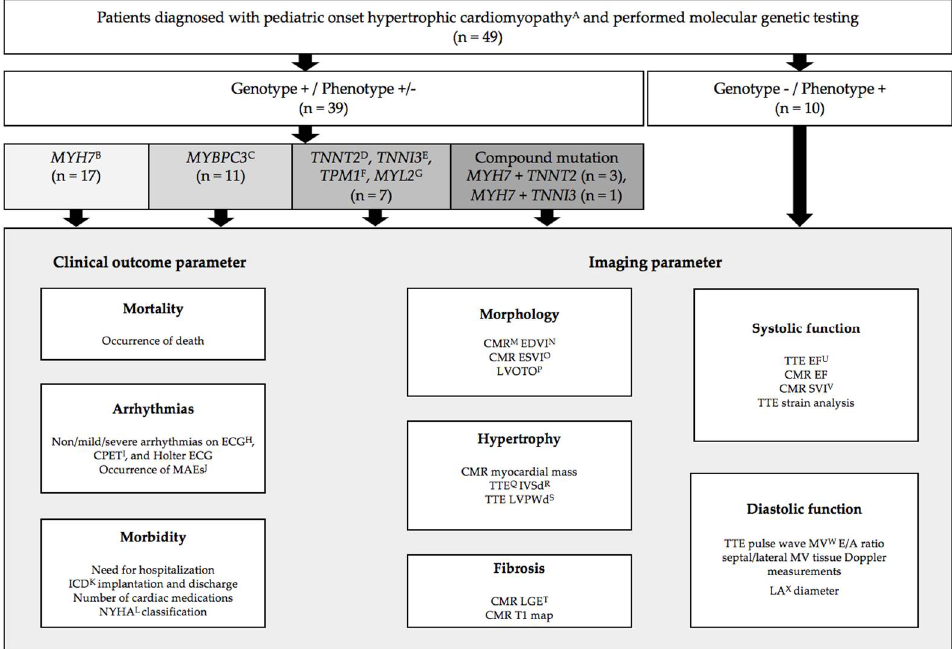
Figure 1. Study design and population with disease-causing mutations in affected genes encoding for sarcomere proteins in the myocardium. Shown are the flow chart of study design and population as well as the distribution of disease-causing mutations in genes encoding for sarcomere proteins in the myocardium as schematic illustrations of the affected proteins of the contractile apparatus of the cardiomyocyte in relation to their location of the thick and thin filament: β myosin heavy chain (MYH7), myosin binding protein C (MYBPC3), cardiac troponin T2 (TNNT2), cardiac troponin I3 (TNNI3), α tropomyosin (TPM1), myosin light chain 2 (MYL2). A , isolated hypertrophic cardiomyopathy according to current European Society of Cardiology and American Heart Association definitions; B , β myosin heavy chain; C , myosin binding protein C; D , cardiac troponin T2; E , cardiac troponin I3; F , α tropomyosin; G , myosin light chain 2; H , electrocardiogram; I , cardiopulmonary exercise test; J , major arrhythmic events: reanimation and/or appropriate discharge of cardioverter-defibrillator and/or sudden cardiac death; K , implantable cardioverter defibrillator; L , New York Heart Association; M , cardiac magnetic resonance imaging; N , end-diastolic volume index; O , end-systolic volume index; P , left ventricular outflow tract obstruction; Q , transthoracic echocardiography; R , end-diastolic septal wall thickness; S , end-diastolic left ventricular posterior wall thickness; T , late gadolinium enhancement; U , ejection fraction; V , stroke volume index; W , mitral valve; X , left atrial.